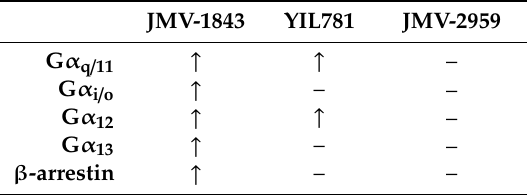
Table 1. Signaling pathways employed by JMV-1843, YIL781, and JMV-2959. An arrow upwards denotes activation of a pathway by binding of a ghrelin-R ligand. A hyphen denotes no alterations in basal signaling levels induced by binding of a ghrelin-R ligand. YIL781 and JMV-2959 are both not able to recruit β